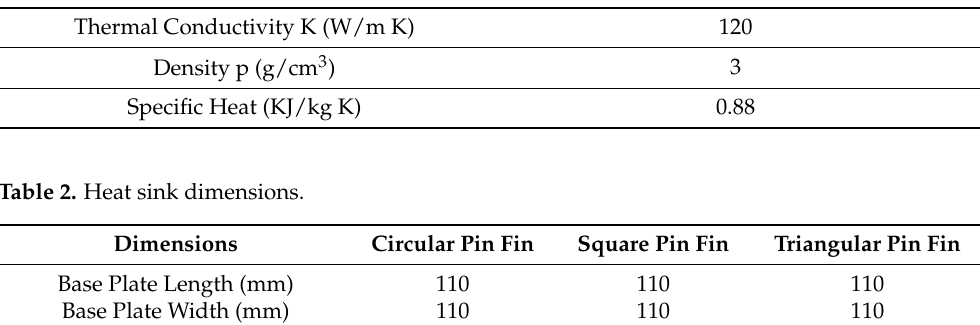
Table 1. Properties of heat sink material.